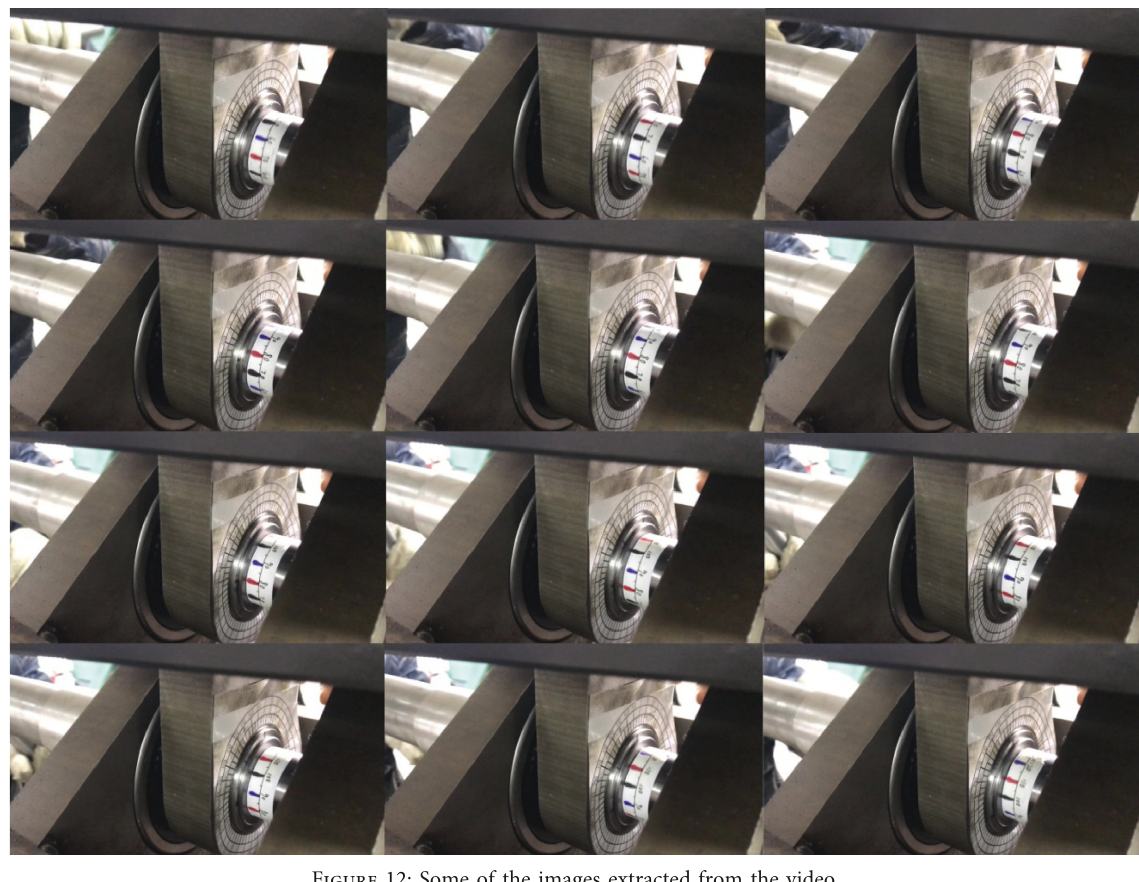
Figure 12: Some of the images extracted from the video.